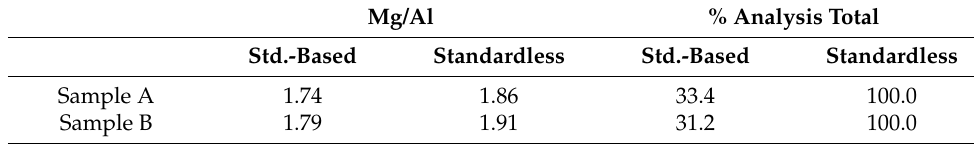
Table 3. Results based on the std.-based and standardless EDS microanalysis. Mg/Al % Analysis Total Std.-Based Standardless Std.-Based Standardless Sample A 1.74 1.86 33.4 100.0 Sample B 1.79 1.91 31.2